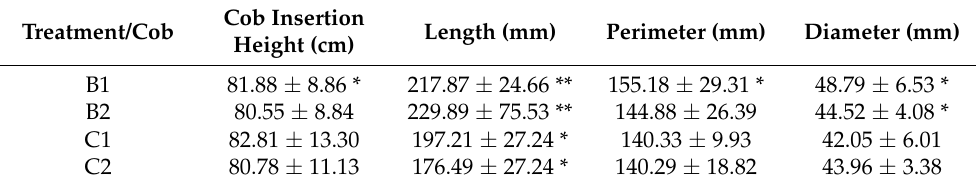
Table 3. Cob morphological data based on treatment. Data are expressed as mean ± standard deviation. Control: plots without biochar; B1: plots supplemented with biochar B1; B2: plots supplemented with biochar B2.